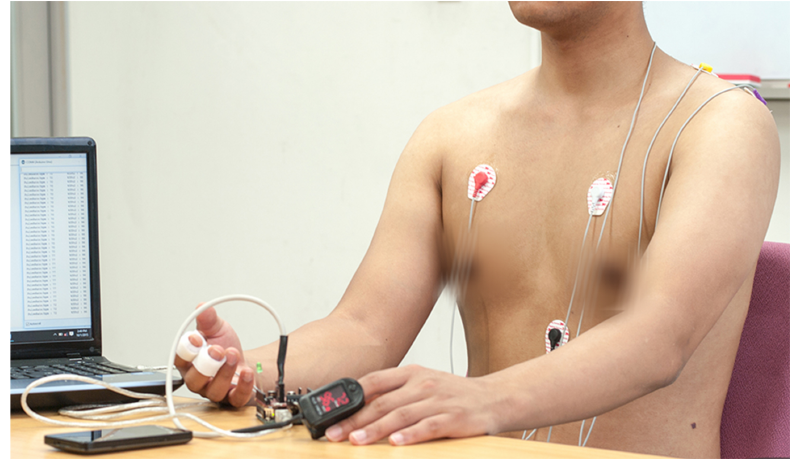
Figure 2. Bio-sensors network to collect psychophysiological observations in an AAL